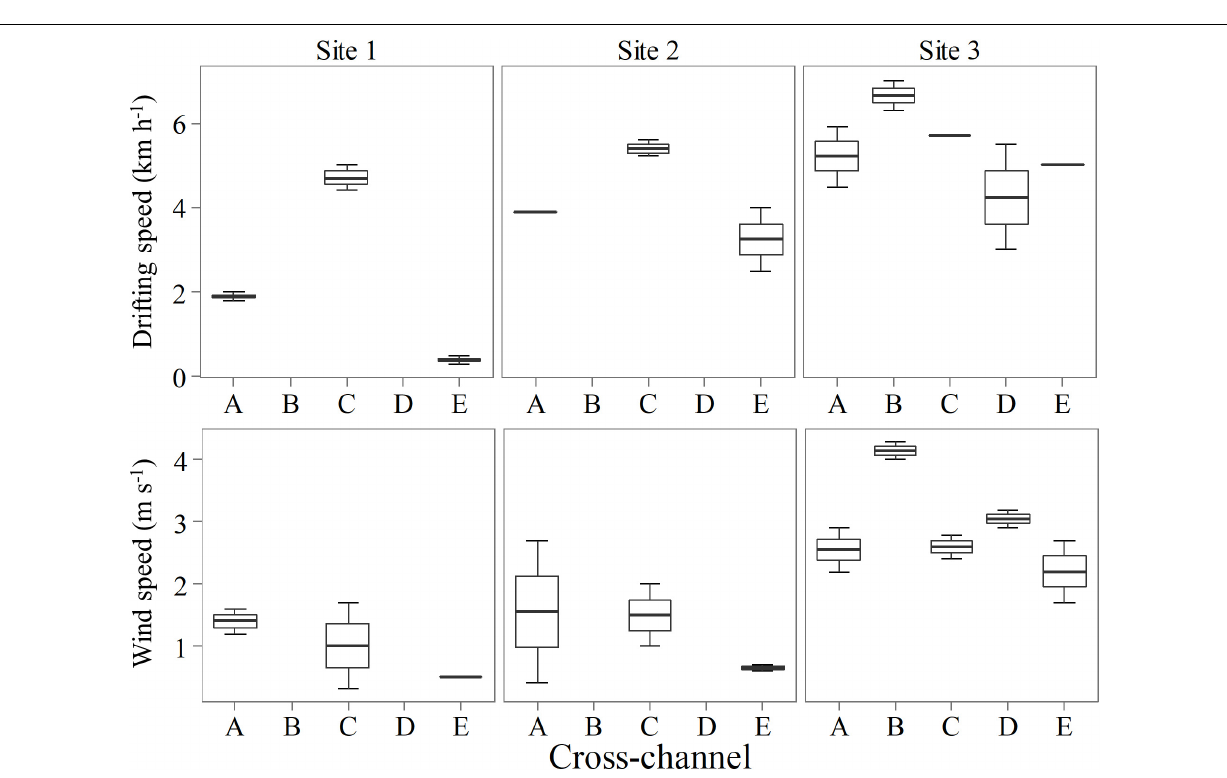
Frontiers in Environmental Science |